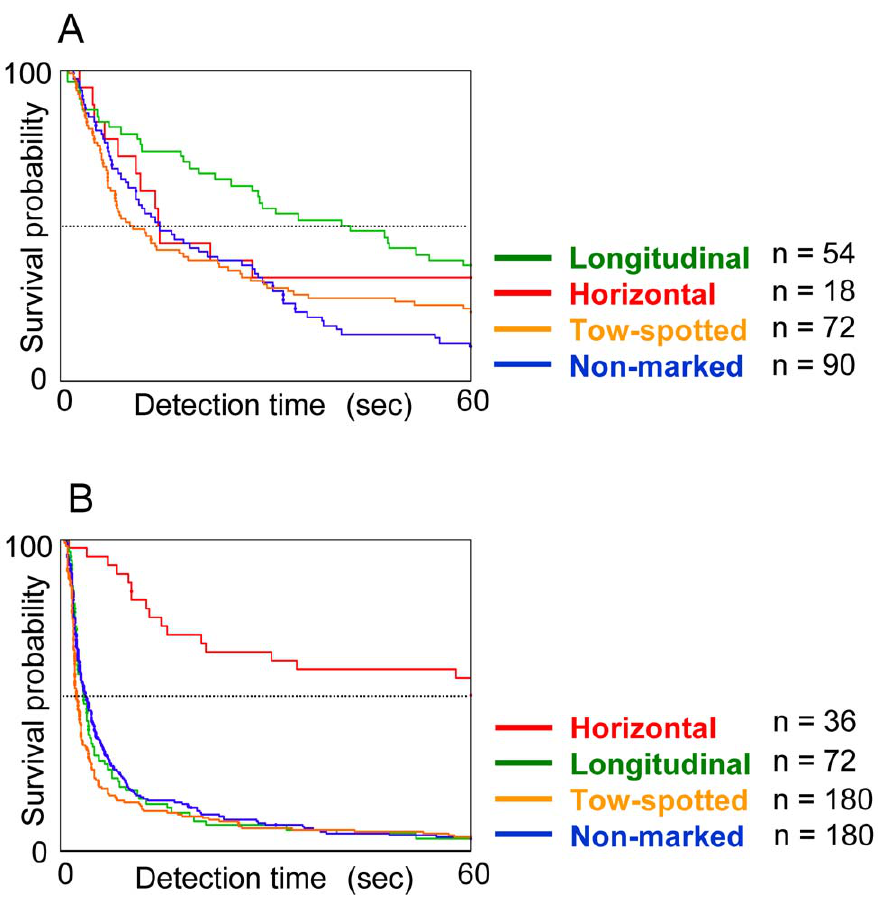
Figure 2. Survival curves of marking-type morphs against grass and sand backgrounds. Curves are the probabilities of surviving human detection as a function of time, based on Kaplan–Meier estimates to account for survival to the end of the experimental period (60 s). (A) Survival curves against grass backgrounds. (B) Survival curves against sand backgrounds. Non-marked morphs, blue lines; spotted morphs, orange lines; longitudinal morphs, green lines; horizontal morphs, red